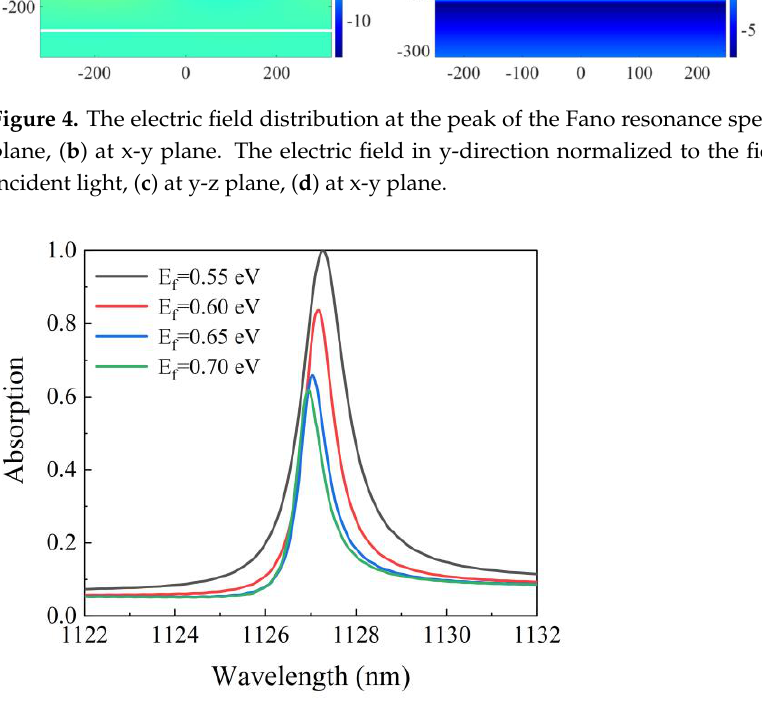
Figure 4. The electric field distribution at the peak of the Fano resonance spectral curve, ( a ) at y-z plane, ( b ) at x-y plane. The electric field in y-direction normalized to the field amplitude of the in- cident light, ( c ) at y-z plane, ( d ) at x-y plane.